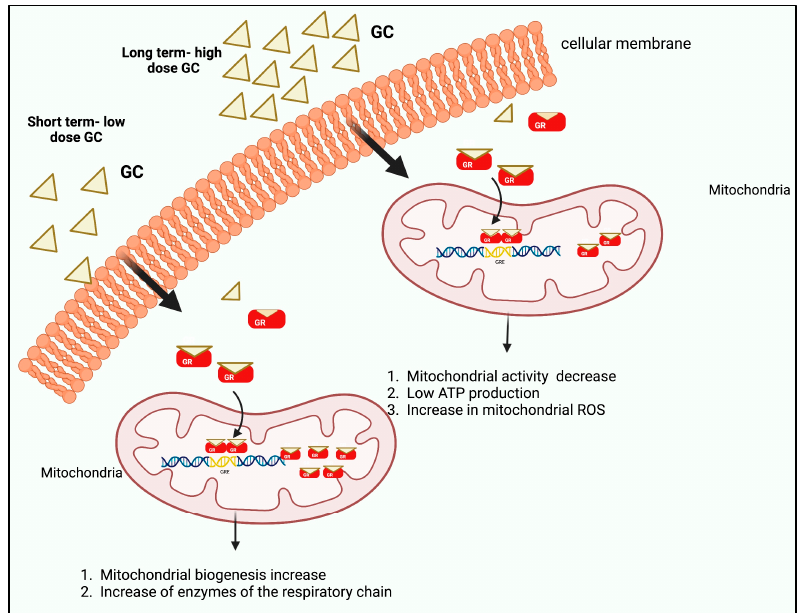
Figure 2. GCs exert biphasic effects on mitochondrial GR translocation. Short-term treatment with high or low doses of CORT/DEX induces the mitochondrial localization of GRs and leads to the increase of the GR/GC complex into mitochondria, thus enhancing mitochondrial function and cel- lular viability. Long-term treatment with high doses of CORT/DEX reduces the mitochondrial lo- calization of GR and downregulates GR/GC complex in mitochondria, leading to mitochondrial dysfunction and apoptosis. Created by Biorender.